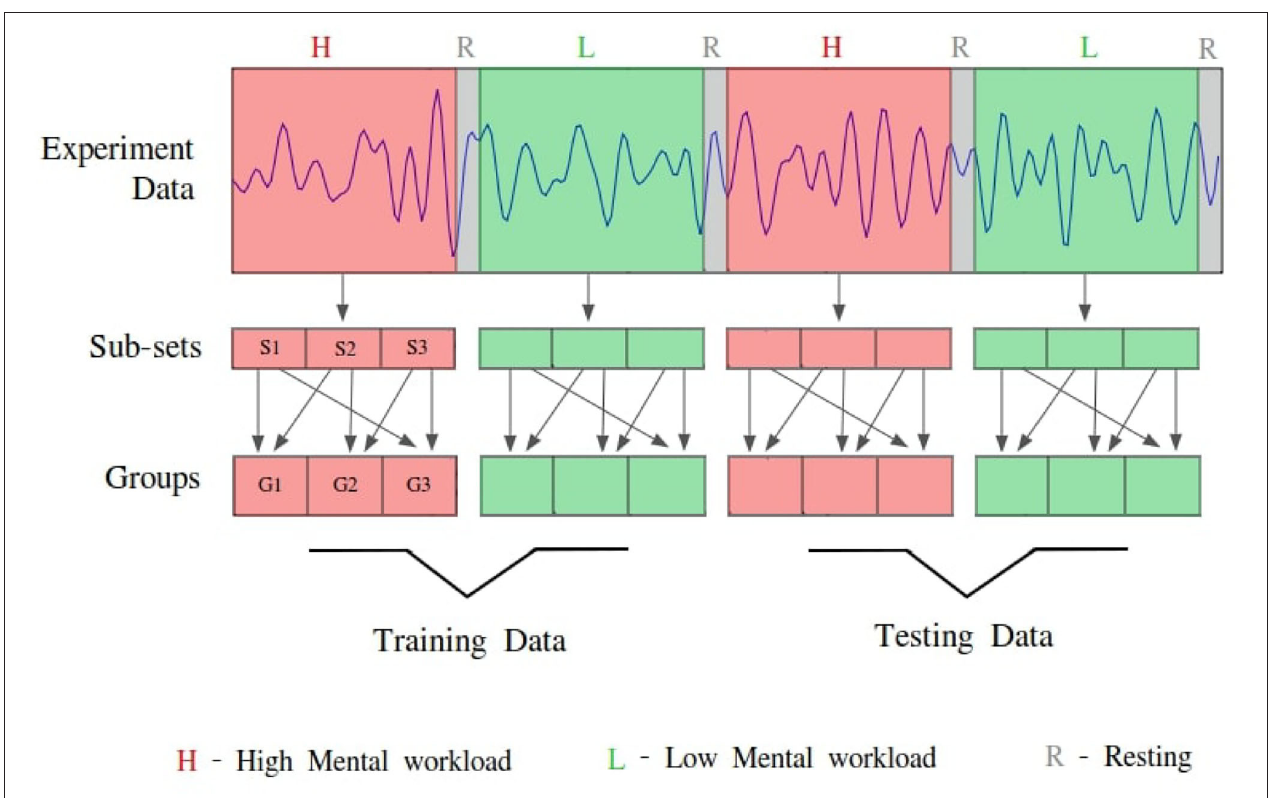
FIGURE 6 | Allocation process of each participant’s data in the ecological classification validation design for creating testing and training sets. Data from each condition (High:H, Low:L) are divided into three subsets (S1, S2, and S3). These subsets are used to create three groups (G1, G2, and G3; e.g., G1 = S1 +